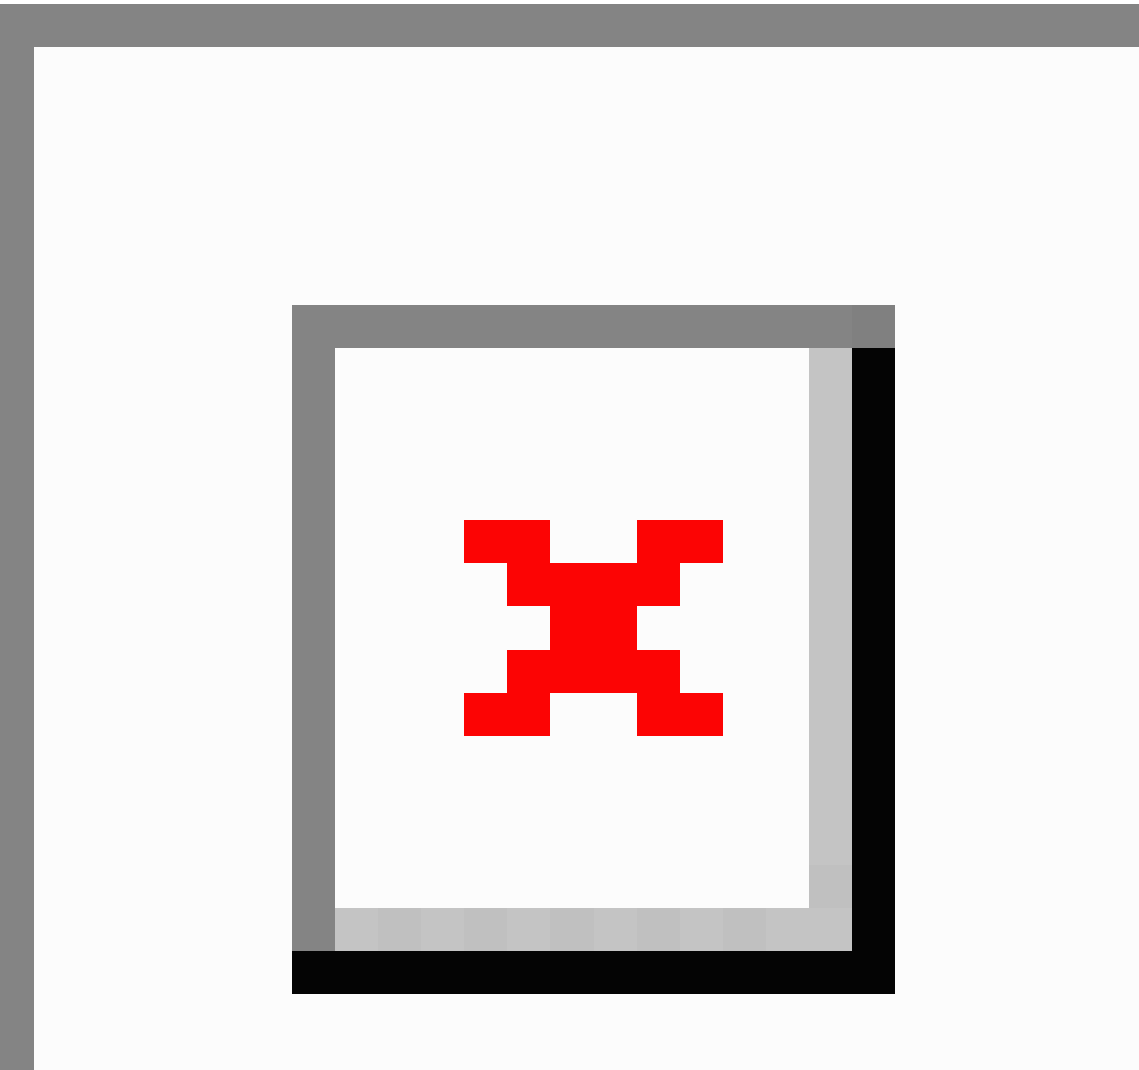
Figure 6. A plot of average paper and app PHQ-9 scores by patient (Pearson correlation coefficient, r =.84). Identical scores would lie on the added